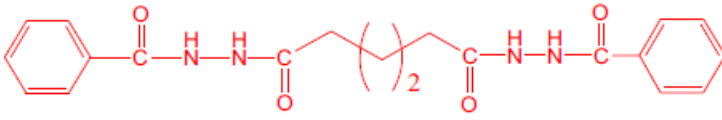
Figure 1. The structure of TMC-306 (hydrazide compound) [7].